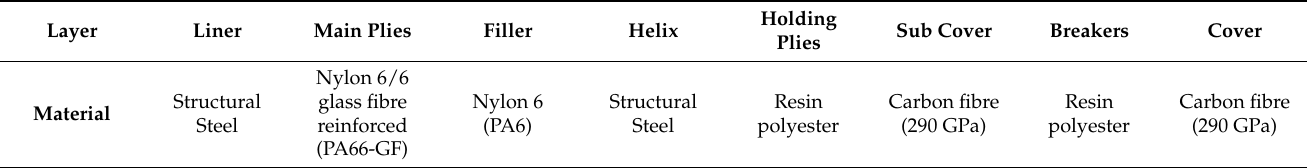
Table 2. Material consideration for reeled hose